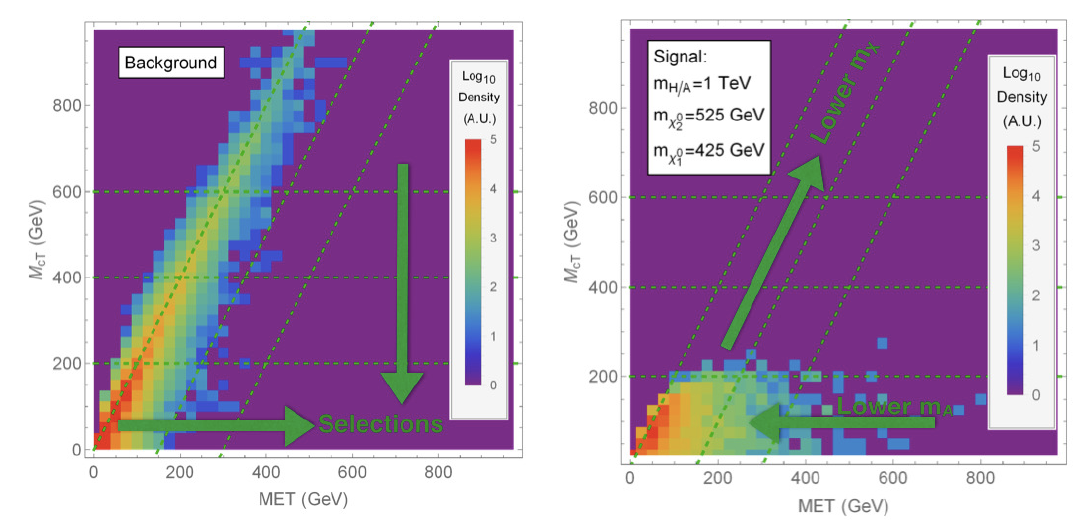
Figure 5 . The background (left panel) and signal (right panel) distributions in the =E T (cid:0) m cT ( ‘‘; =E T ) plane. The signal distribution is shown for a representative benchmark point with m H = m A = 1 TeV, m (cid:31) = 425 GeV, and m (cid:31) = 525 GeV. In the left panel, we show with 1 2 dashed green lines and arrows the direction of the selection grid described in the text. In the right panel, green arrows indicate how the signal distribution shifts as the heavy Higgs or neutralino masses are